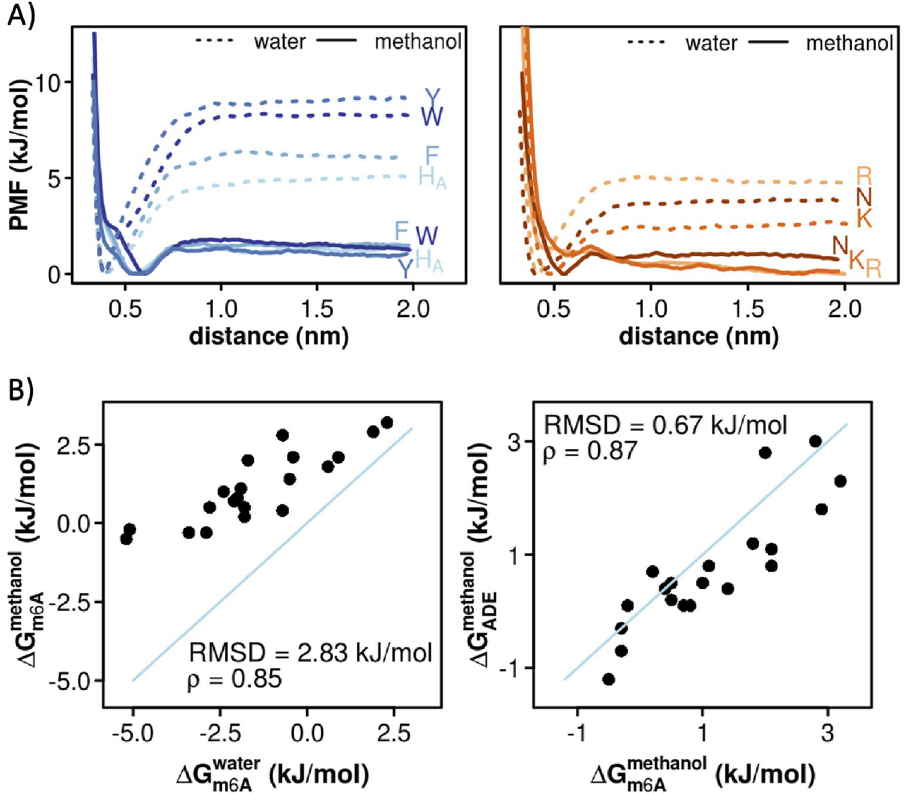
Figure 3. Absolute binding free energies of protein side chains for m 6 A. ( a ) PMF curves derived for protein side chains whose affinities for m 6 A change significantly (> 3.4 kJ/mol) depending on the surrounding solvent. In the left panel, affinities of aromatic side chains for m 6 A get less favorable with a decrease in the dielectric constant of the surrounding environment (from water to methanol). In the right panel, the same trend is depicted, but for polar and positively charged side chains. ( b ) A comparison between m 6 A sidechain affinities derived in water and methanol (left panel) and sidechain affinities for m 6 A and ADE 12 derived in methanol with the corresponding Spearman correlation coefficients and RMSD